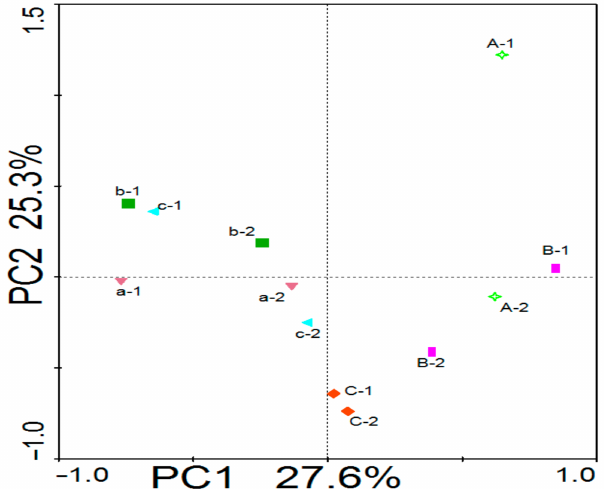
Figure 4. Principal coordinate analysis (PCA) score plot of different wetland samples based on weighted UniFrac metrics. Two categories were clustered, including the DMP group and the NO DMP group. Table 2. Shannon–Wiener diversity and richness index of substrate in VFCW.